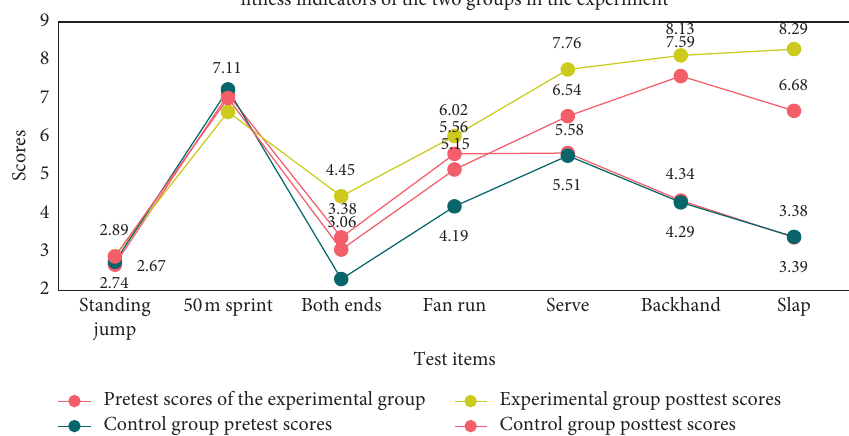
Figure 3: Comparison of the pretest and posttest scores of the physical fitness indicators of the two groups in the experiment. Sports visual importance scale for different sports